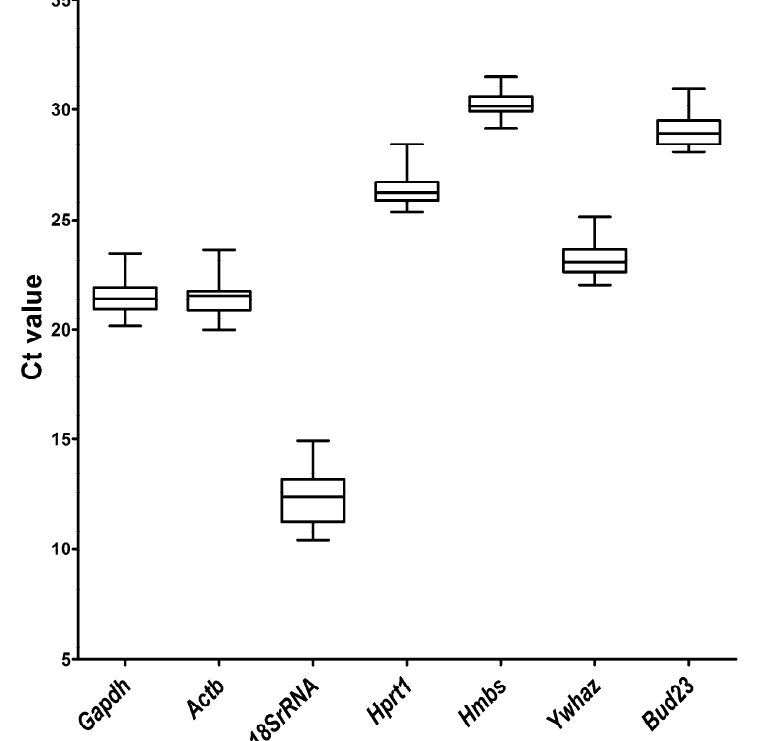
Figure 2. Distribution of the qRT-PCR cycle threshold (Ct) values for the candidate reference genes in all experimental groups of gerbil hippocampi (n = 30). A line across the box is depicted as the median. The boxes indicate the 25th and 75th percentiles. Whiskers represent the maximum and minimum values.